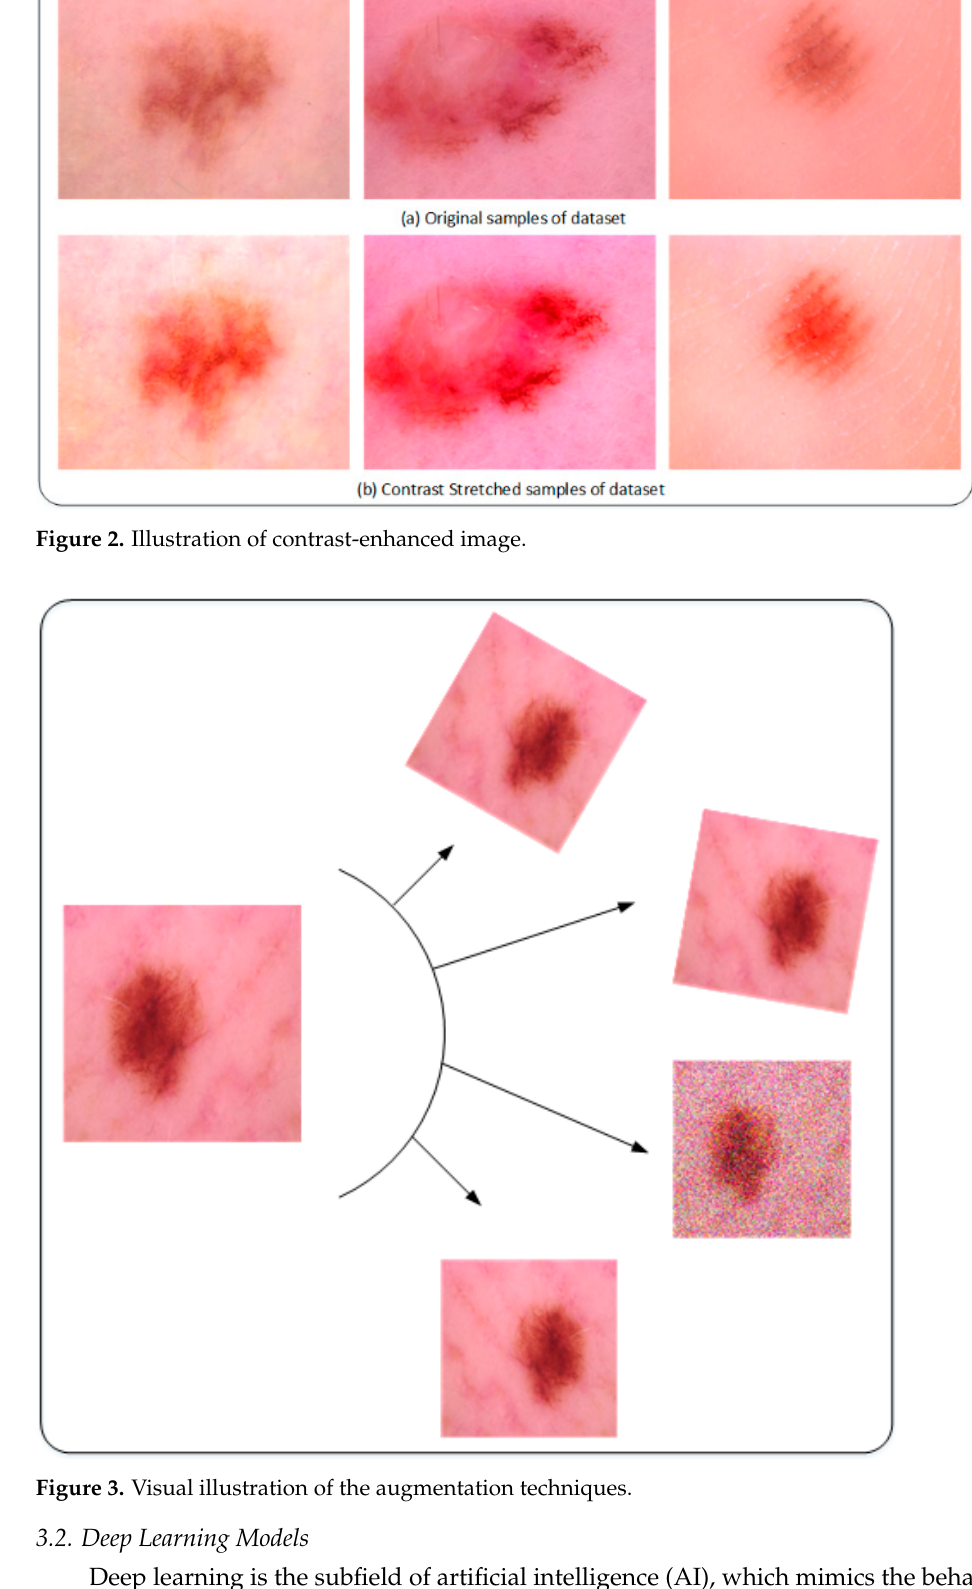
Figure 2. Illustration of contrast-enhanced image; ( a ) original dataset, ( b ) contrasted stretched da- taset.